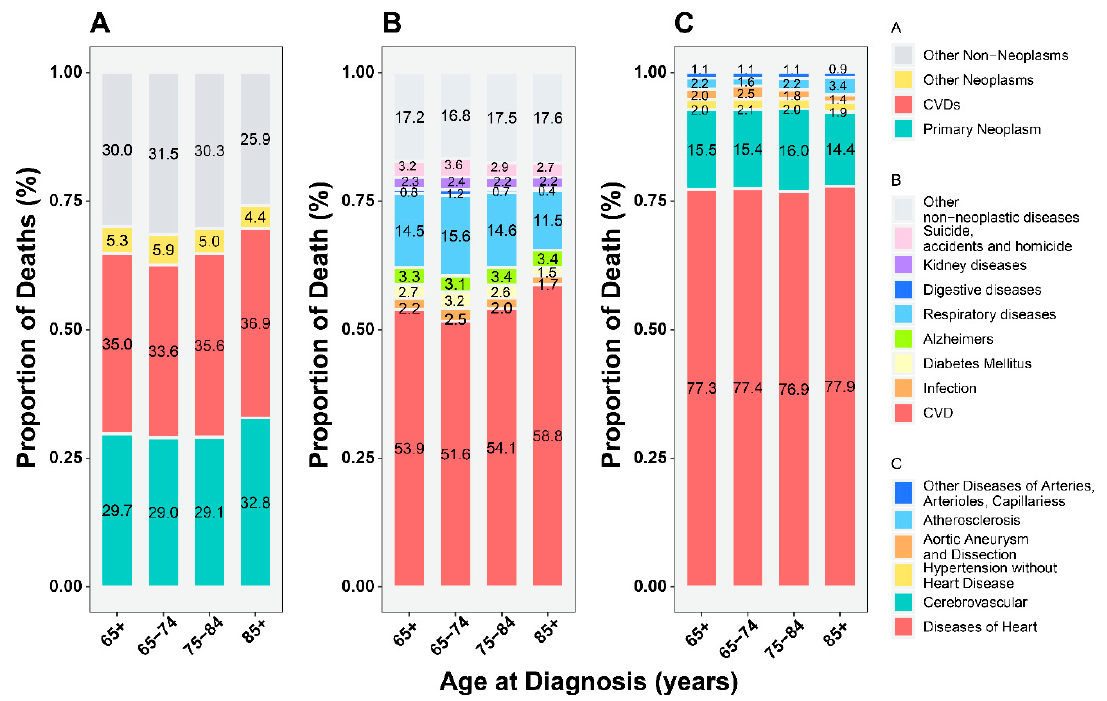
Figure 1. The proportion of deaths among older patients ( ≥ 65 years) with bladder cancer. ( A ) All causes of deaths; ( B ) all causes of non-cancer deaths; ( C ) all causes of CVD-related deaths. Abbrevia- tions: CVD, cardiovascular